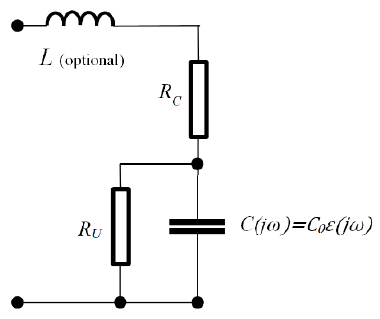
Figure 1. A supercapacitor equivalent circuit.